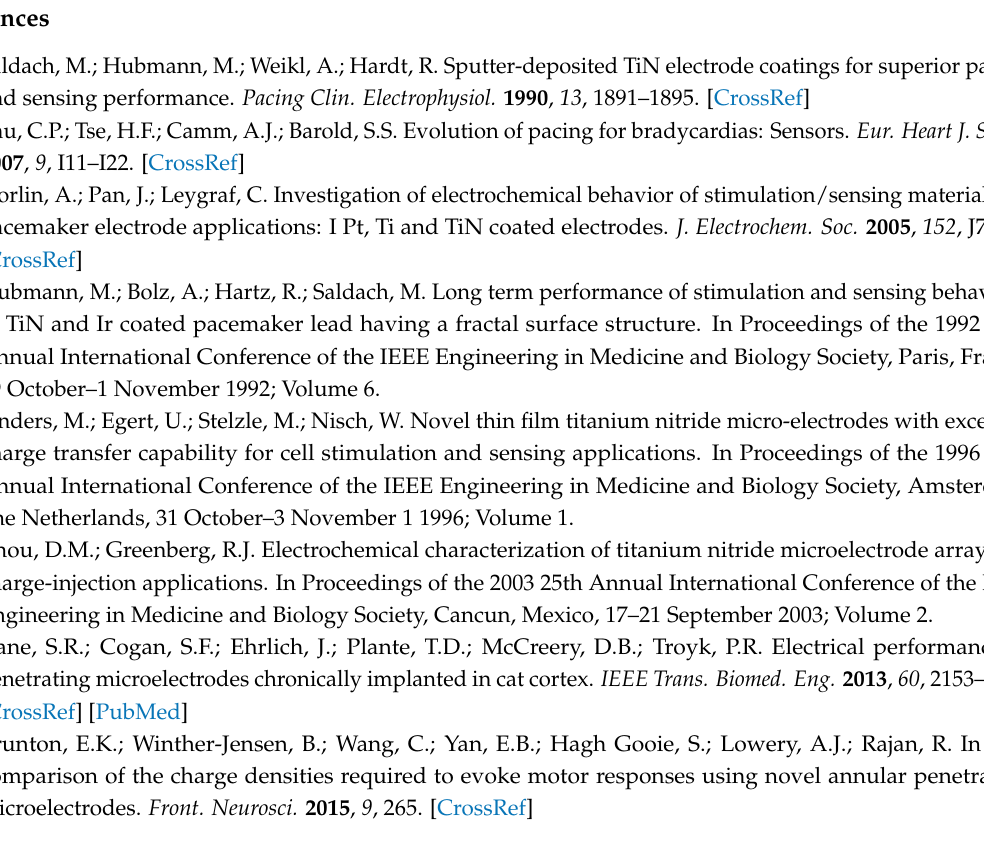
Figure S1: (a) Tissue around the tip of an electrode stimulated at 20 mA-200 Hz after 1 week of implantation. The tissue was stained using haematoxylin and eosin (H&E), which is the most commonly applied stain in medical diagnostics. Some inflammatory cells can still be observed but capsule formation has begun to take place. (b) Cells around the silicone part of the electrode appear very similar to those around the electrode tip, indicating no signs of stimulation-induced tissue damage. Figure S2: (a) The tissue around electrodes in group 1 showed no signs of tissue damage upon sacrifice. (b) The tissue around electrodes in group 2 showed some redness around the electrode tip, which likely is due to tissue damage. (c) The tissue around the electrode tips of electrodes in group 3 showed obvious tissue damage but the tissue around the insulated parts was unaffected. (d) The tissue around the electrode tips of electrodes in group 4 showed even more extensive tissue damage and bleeding. Nevertheless, the tissue around the insulated parts was